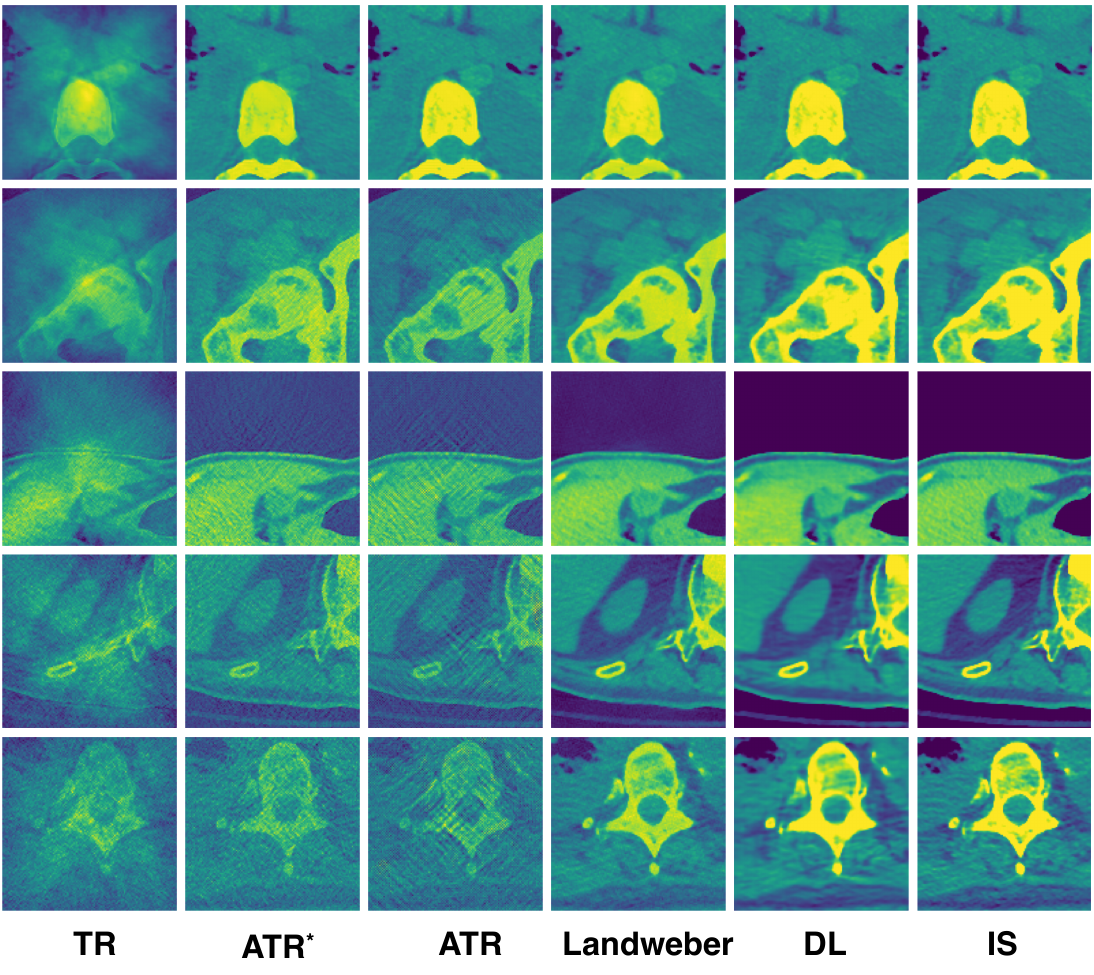
Figure 4. Reconstruction in a homogeneous